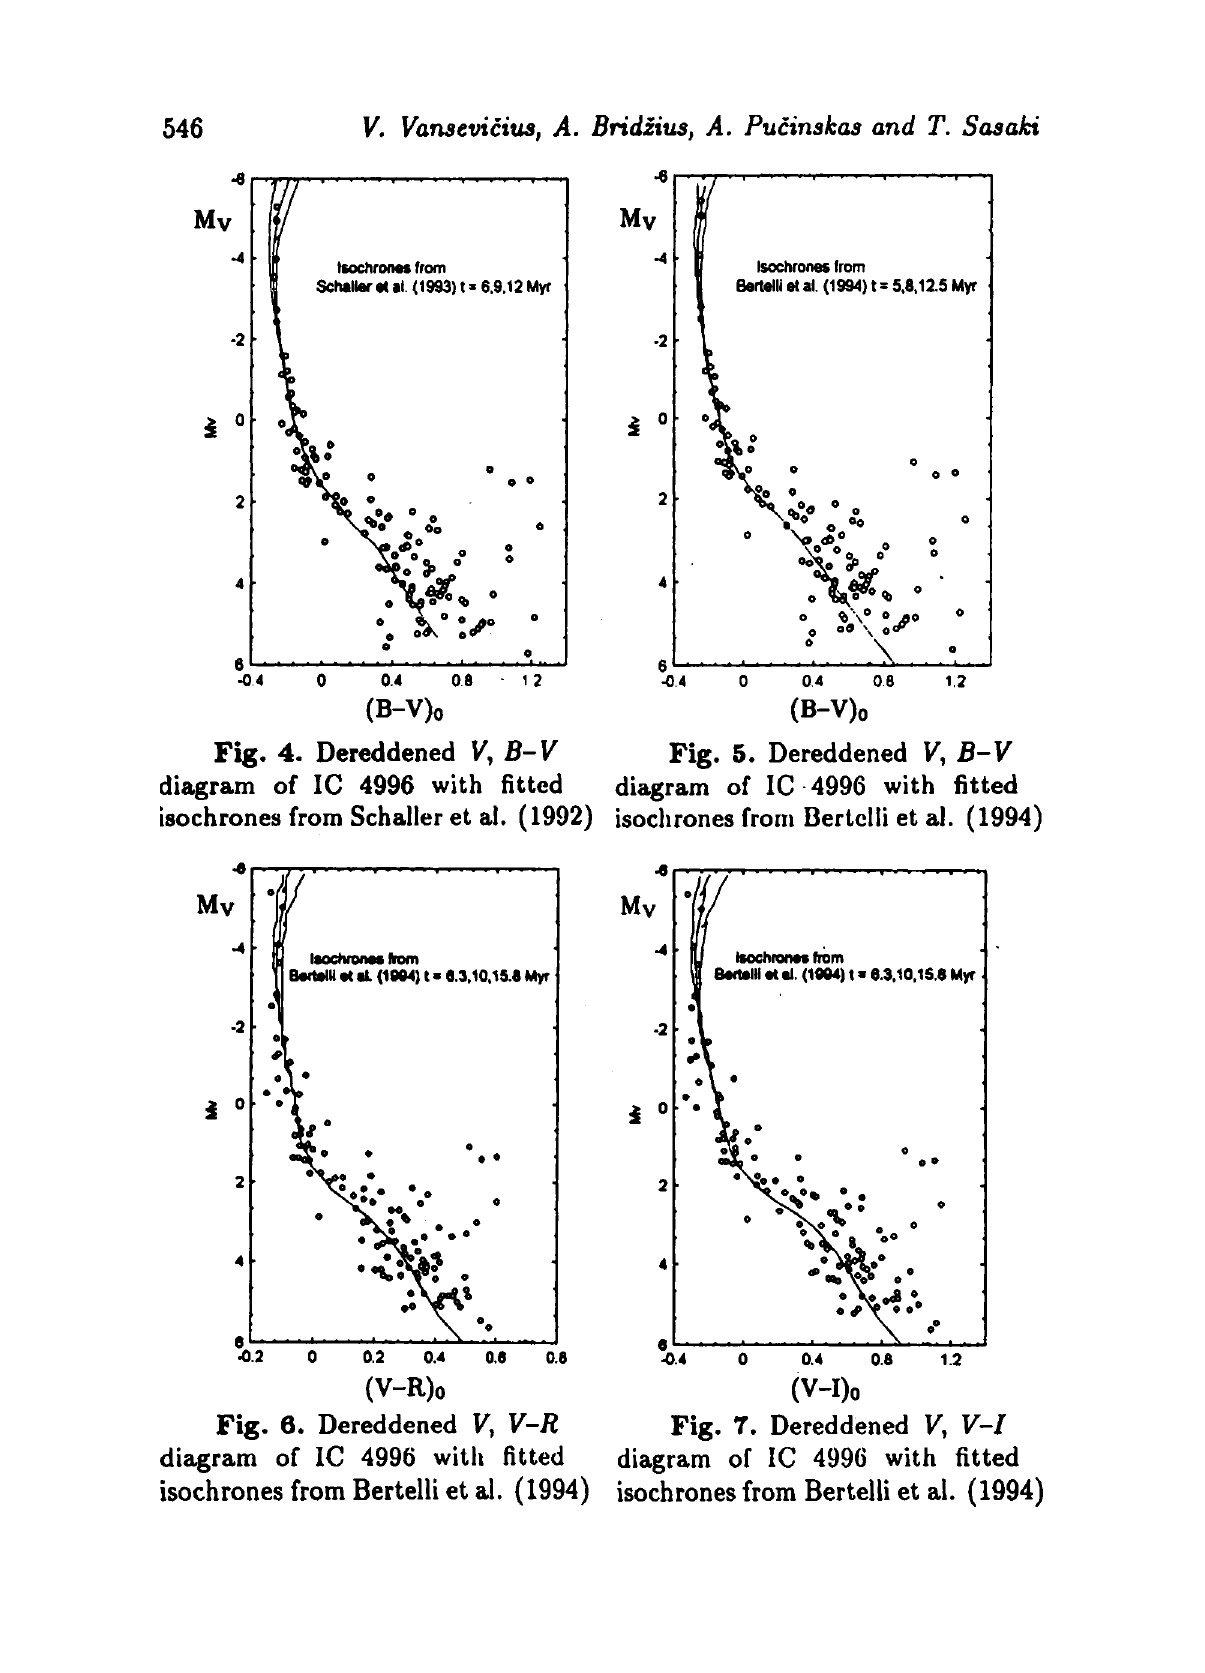
Fig. 7. Dereddened V, V-I diagram of IC 4996 with fitted isochrones from Bertelli et al.